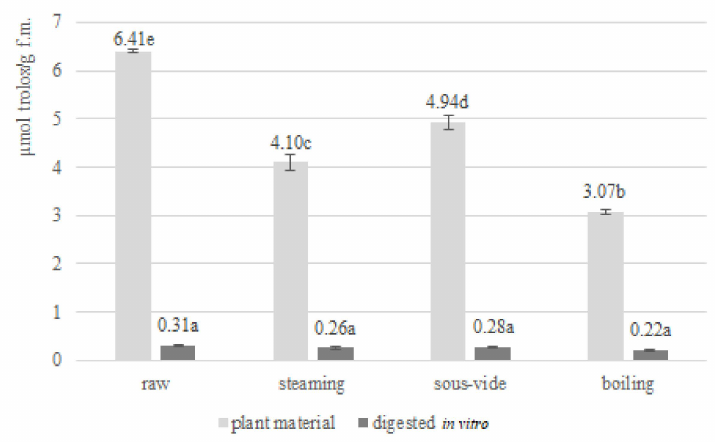
Figure 3. DPPH antioxidant activity ( µ mol trolox/g f.m.) in raw and thermally-treated Brussels sprouts before and after in vitro digestion. Means followed by the same letter (a,b,c,d,e) are not significantly different ( p ≤ 0.05); f.m.—fresh